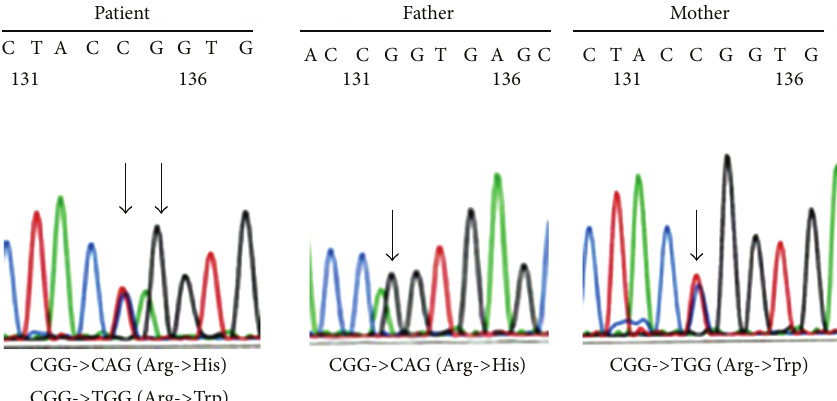
Figure 2: Sequence analysis of the SLC12A3 gene is shown, which encodes the thiazide-sensitive Na + /Cl − cotransporter. The patient had compound heterozygous mutations at codon 642, namely, CGG- > CAG (Arg642His) that was inherited from his father and CGG- > TGG (Arg642Trp) that was inherited from his mother. His elder brother had a heterozygous mutation in this codon (R642H) (data not